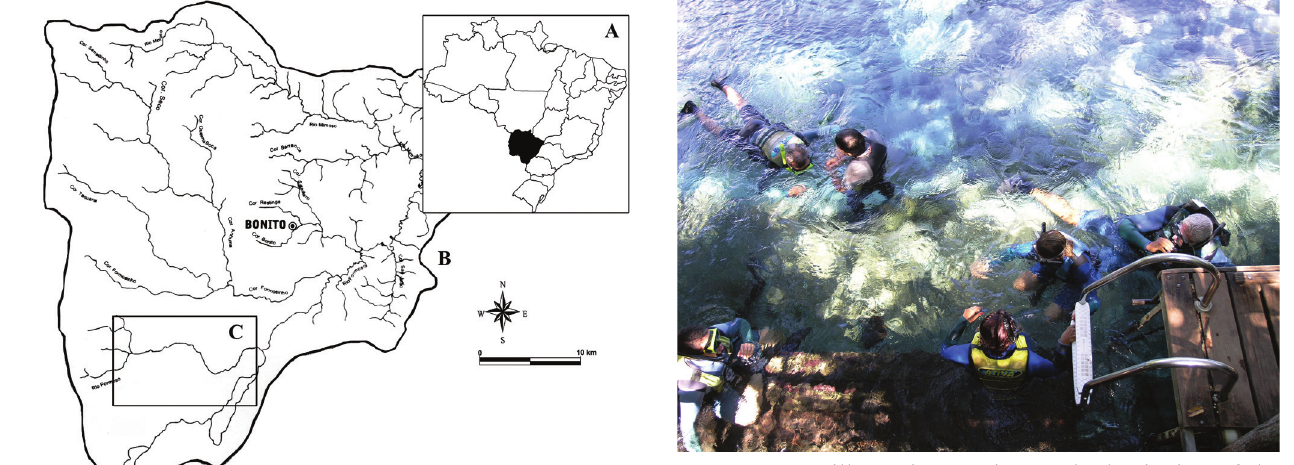
Fig. 2. Image illustrating tourists at the beginning of the snorkeling excursion (Lima, 2008).